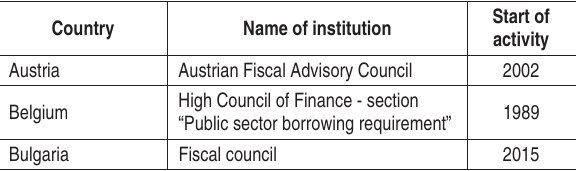
Table 1. List of independent fiscal councils in